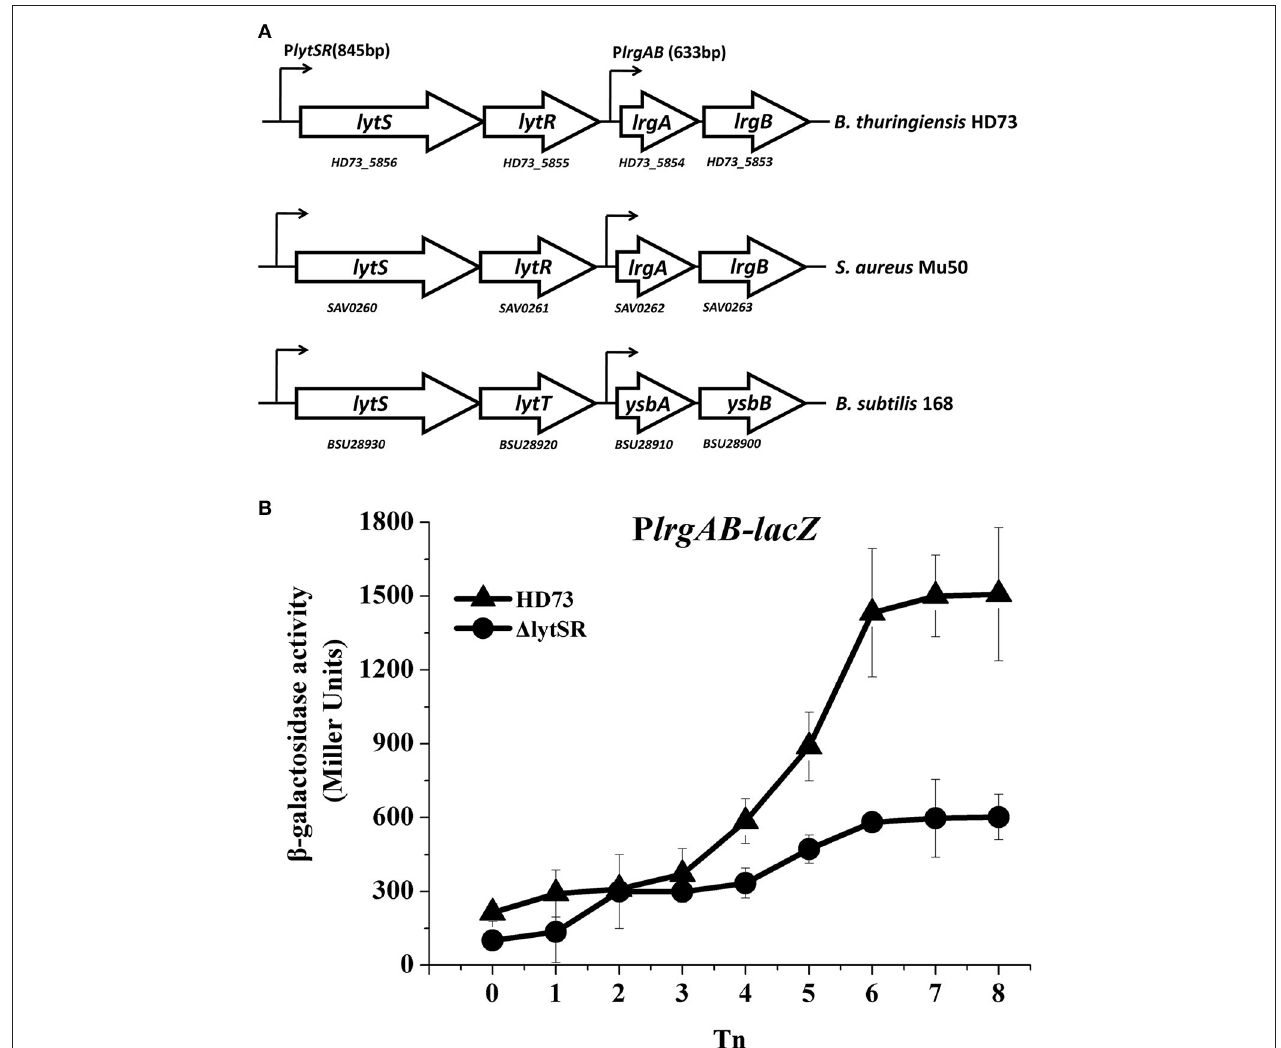
FIGURE 1 | P lrgAB transcription in wild-type Bt HD73 and the lytSR mutant. (A) Gene organization at the lytSR – lrgAB locus in Bt HD73, S. aureus and B. subtilis . White arrows represent open reading frames (ORFs); small arrows denote the lengths of promoters upstream from the lytS and lrgA genes in Bt . (B) β -galactosidase activity from the lrgAB promoter (P lrgAB ) in HD73 ( N ) and lytSR mutant (•) grown in SSM. T 0 is the end of the exponential phase; T n is n hours after T 0 . Values represent the means of at least three independent replicates; error bars represent standard